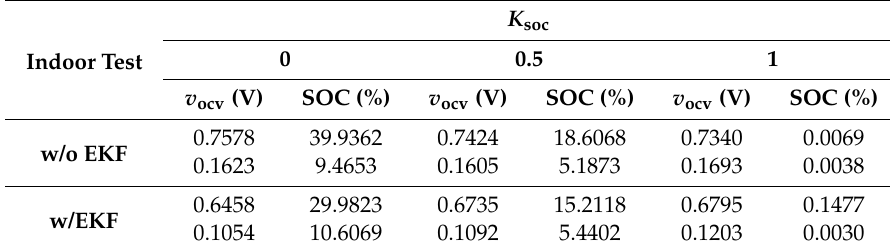
Table 2. Outdoor test result (0 kg payload).